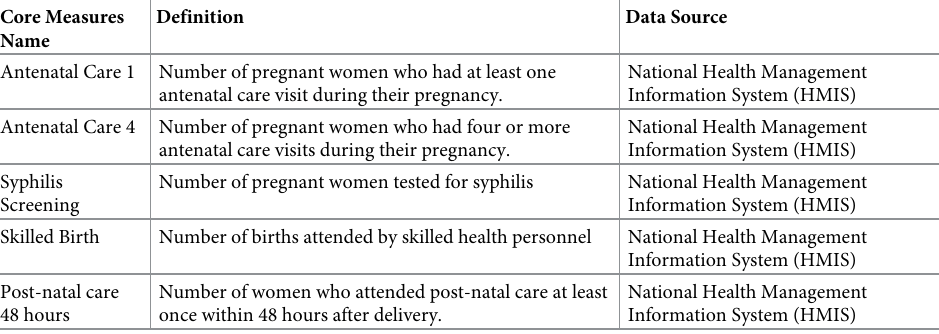
Table 1. HMIS-derived core measures used to track progress in the improvement